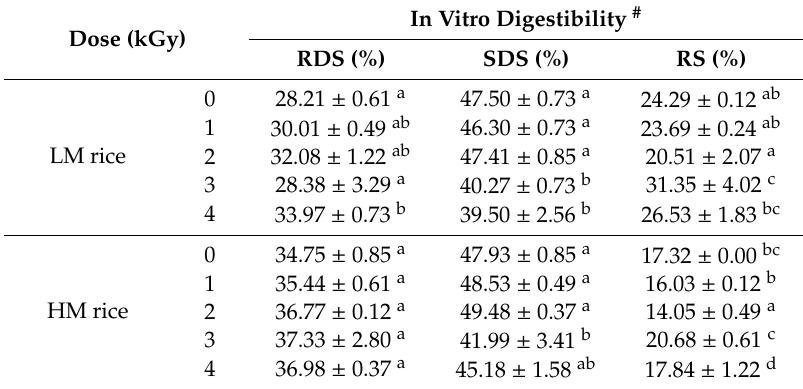
Table 3. In vitro digestibility of the starches isolated from rice grains under various irradiation doses *. Dose